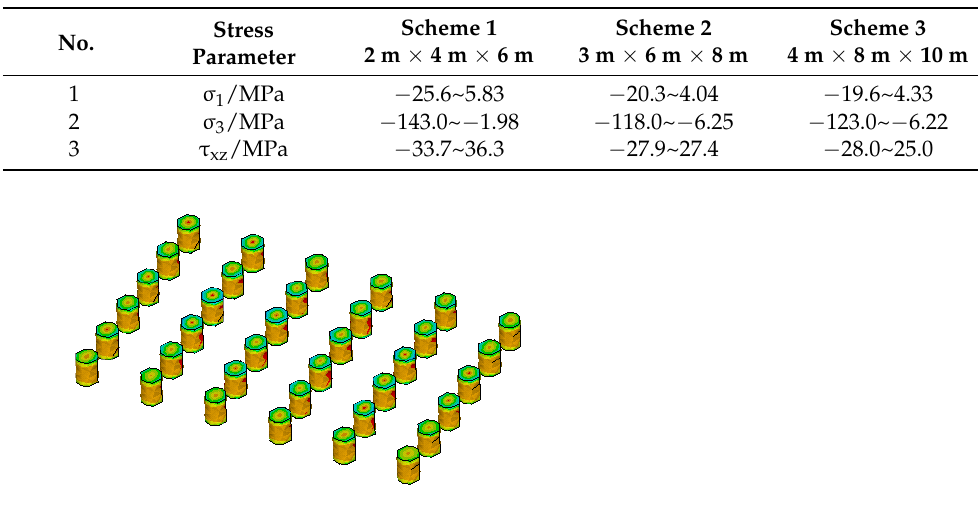
3; ( d ) Scheme 4; ( e ) Scheme 5; ( f ) Scheme 6; ( g ) Scheme 7; ( h ) Scheme 8; ( i ) Scheme 9.